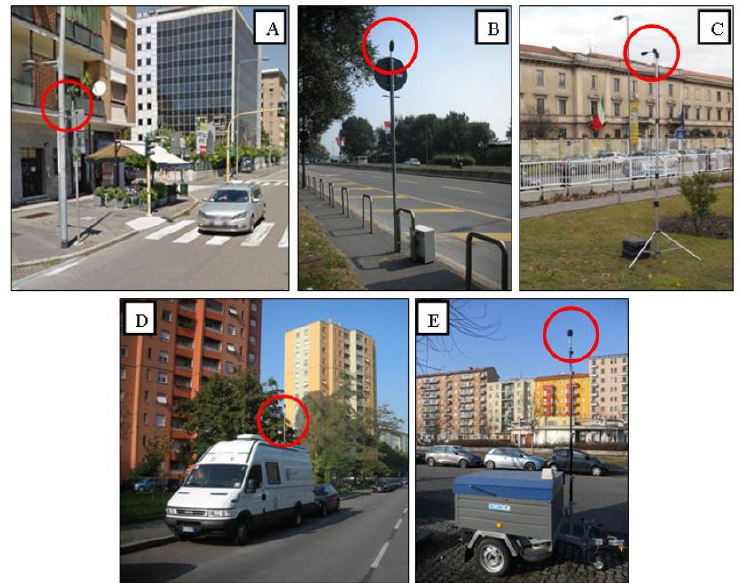
Figure 2. The monitoring stations used during the noise measurement campaigns (red circles). ( A ) Fixed monitoring stations; ( B , C ) Semi-permanent monitoring stations; ( D , E ) Monitoring stations placed on cart or on mobile laboratory. All monitoring stations must be equipped with at least a class 2 sound level meter, which is able to produce the main noise indexes and the spectral trends in third-octave bands with a temporal resolution of 1 s. The monitoring activity is sized on a minimum measurement time of 24 h, starting at 6:00 a.m. and possibly extended on several days [68]. The measured signals at 1 s resolution [68] were integrated to obtain the equivalent lev- ( τ ) ( t , s ) , where τ is the temporal interval of interest, t = n τ ( n ≥ 1) is the time within els L eq i the day at resolution τ , and s i (with i = 1, N m ) is the i th measurement site. In our